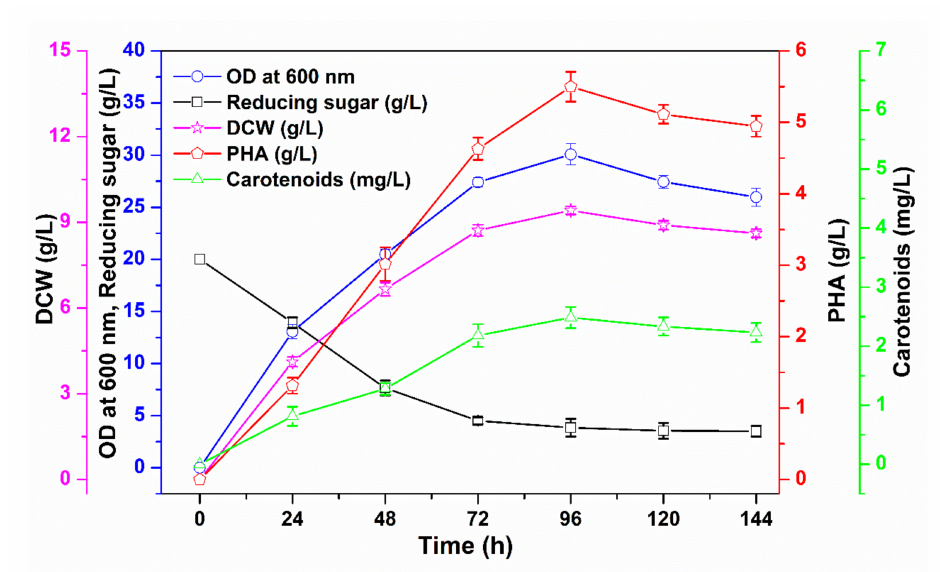
Figure 6. Time profile of OD at 600 nm, DCW, PHA accumulation, carotenoid production, and substrate utilization by Haloferax mediterranei DSM 1411 using 0.3 N HCl DCB hydrolysate as the carbon source in the fermenter. Data are shown as mean values ± standard deviation (n =